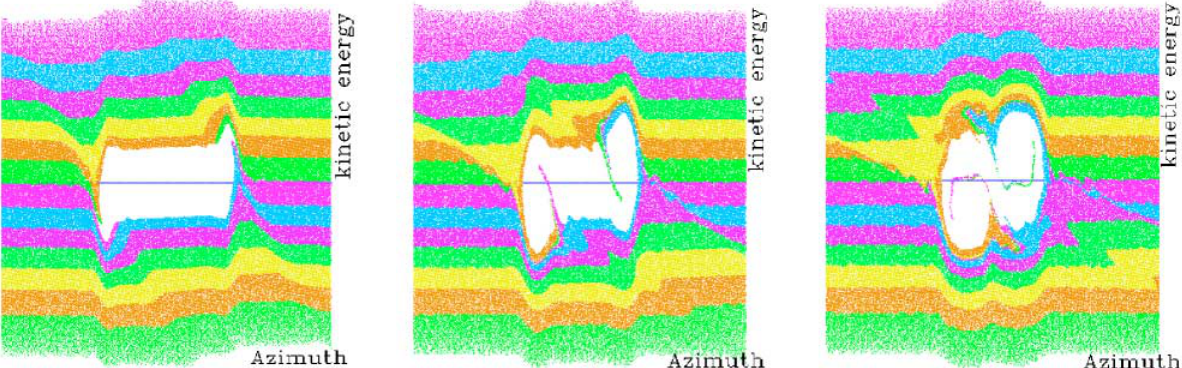
FIG. 23. (Color) Phase space scatter plots (left to right) at 2 14.89 , 2 14.74 , and 2 14.59 ms, respectively. 10 13 protons, 2.8 3 10 5